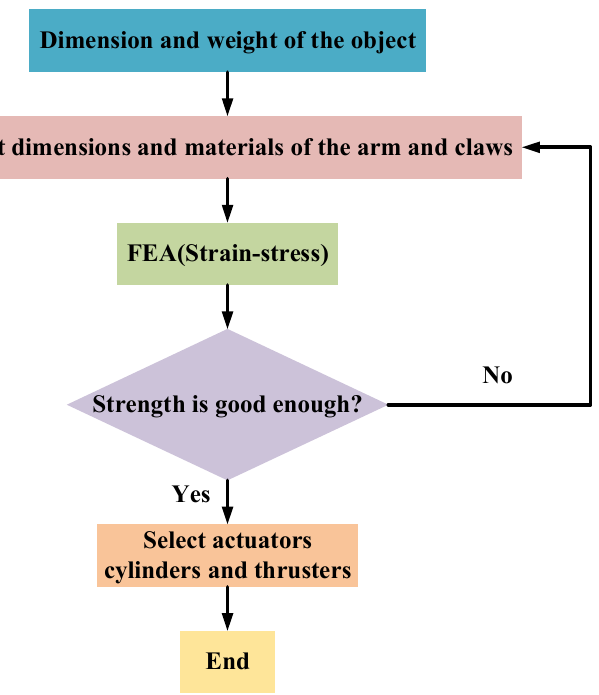
Figure 10. Design flowchart of the manipulator.